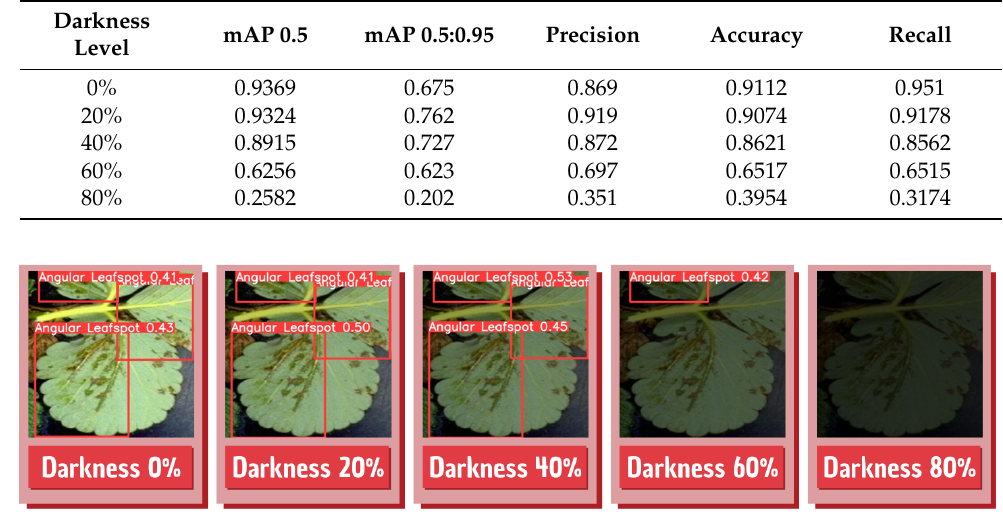
Figure 25. Detections performed in different brightness